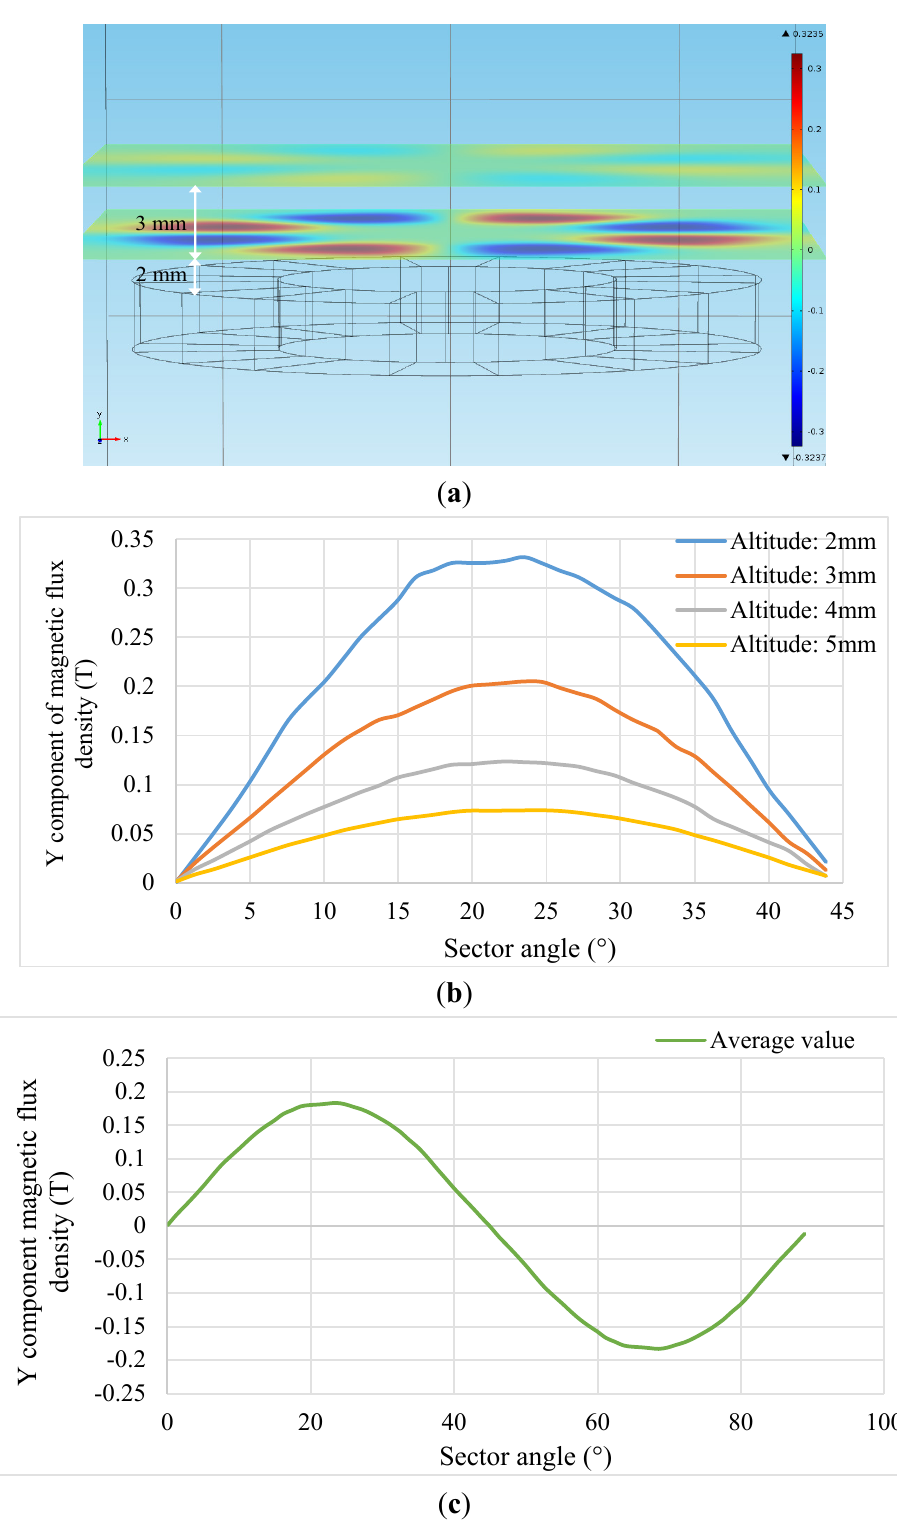
Figure 7. Simulations of the Y component of magnetic flux density. ( a ) The definition of the analyzed region. ( b ) The Y component of magnetic flux density for sector angle ratio (25/20) in different planes. ( c ) The average Y component of magnetic flux density for sector angle ratio